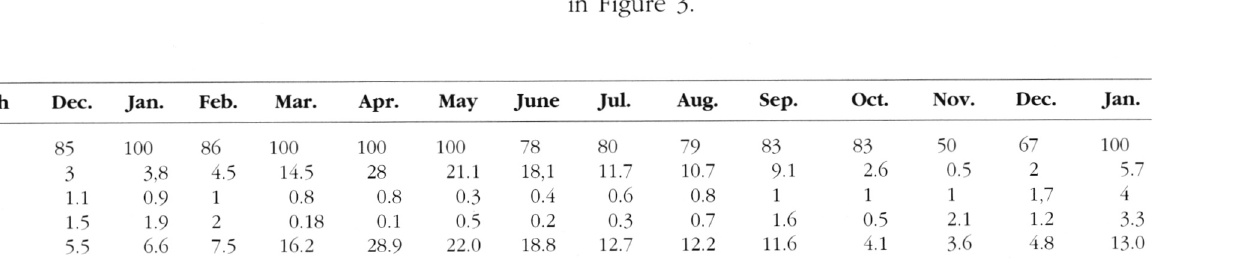
Table I. - Monthly prevalences (Prev.) of permanent lambs (PL) infected with Oestrus ovis and mean Oestrus ovis larval and total bur­